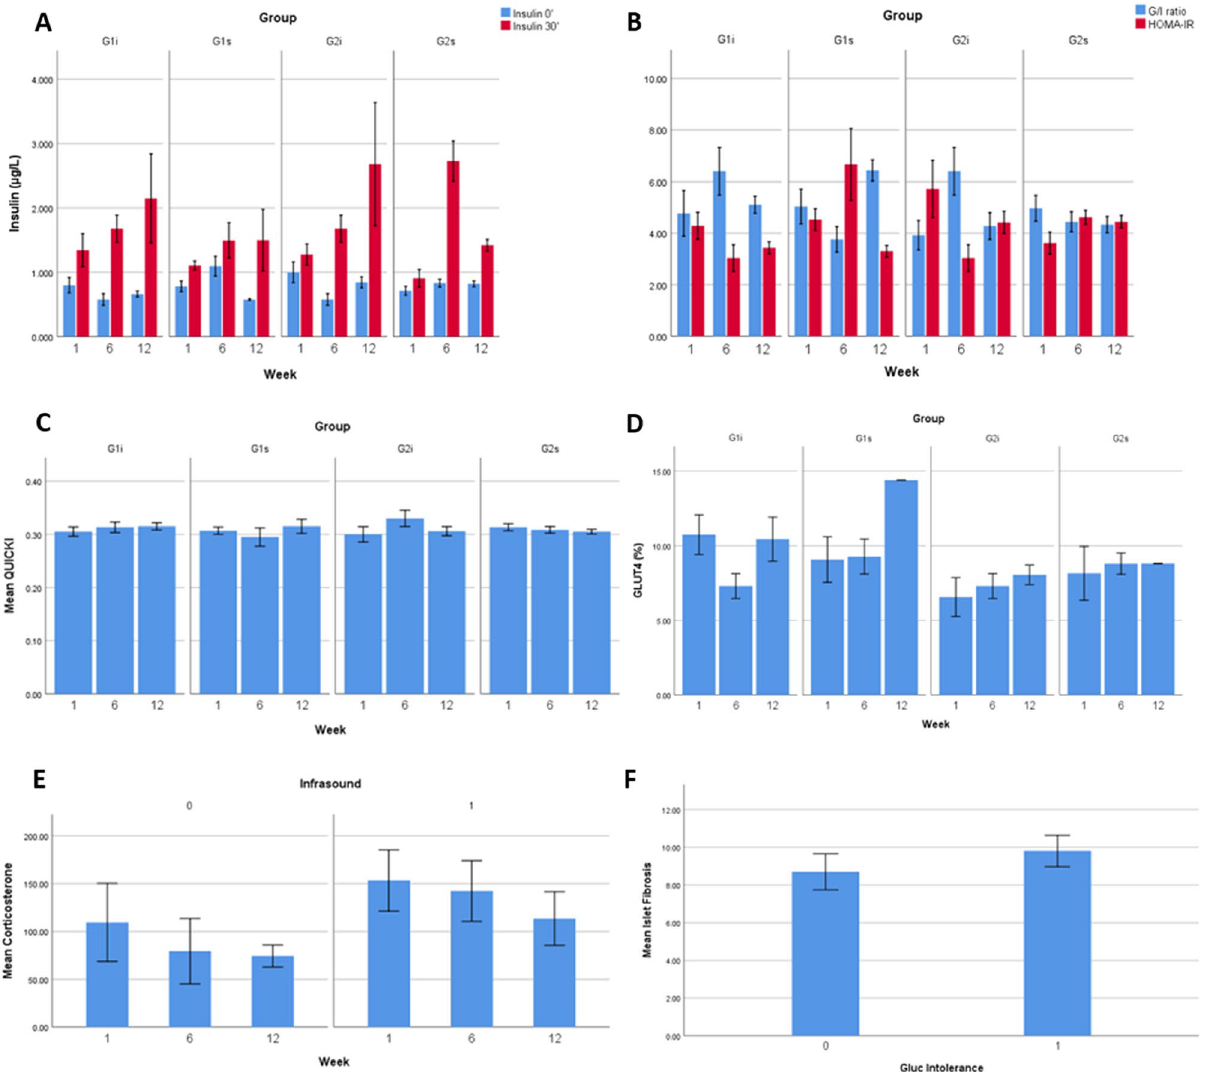
Figure 2. Plasma insulin and corticosterone levels, glucose/insulin ratio, HOMA-IR, QUICKI, muscle GLUT4 ratio and islet fibrosis ratio. Means ± SE of plasma insulin levels ( A ), glucose/insulin (G/I) ratio ( B ), HOMA-IR ( B ), QUICKI ( C ), muscle GLUT4 ratio ( D ), plasma corticosterone levels ( E ) and pancreatic islet fibrosis ratio ( F ), in normal (G1) and glucose intolerant (G2) animals, either kept in silence (s) or exposed to high-intensity infrasound (i), throughout the established experimental